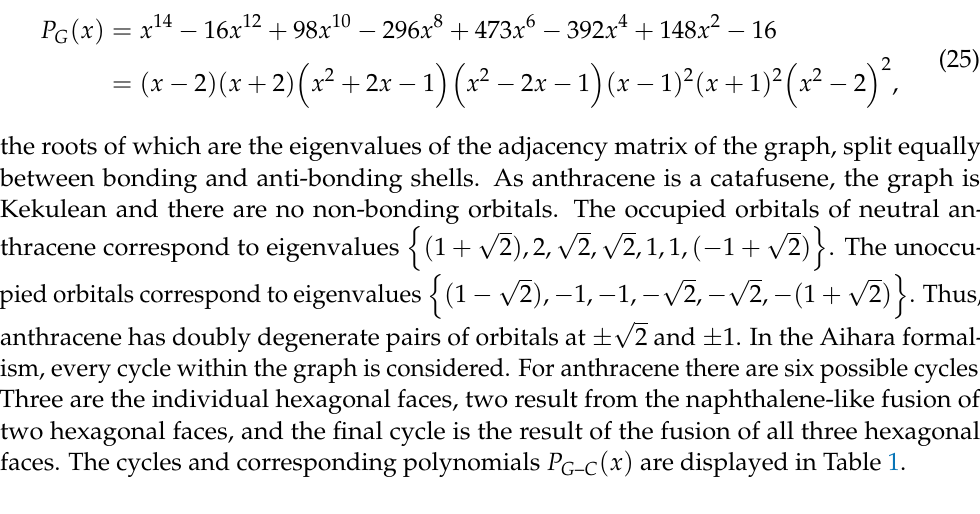
Table 1. Cycles and corresponding polynomials P G – C ( x ) in anthracene. Bold lines represent edges in C ; removal of bold and dashed lines yields the graph G – C